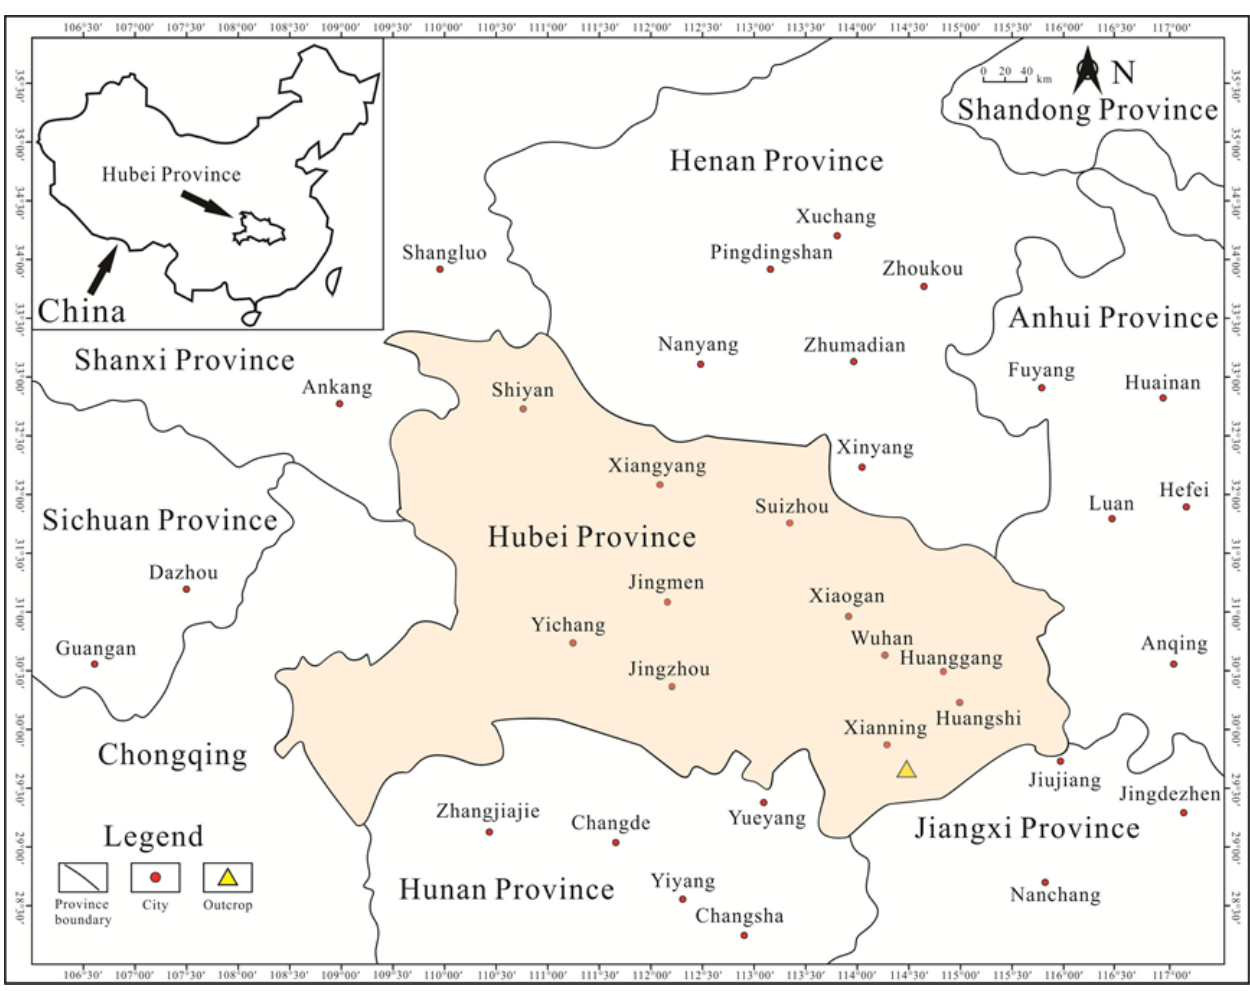
Figure 1. Sampling sites from the Xikeng section in southeastern Hubei Province, China.